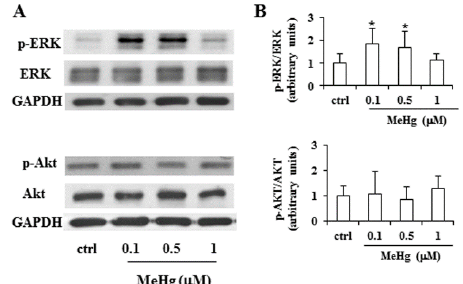
Figure 3. Effects of low doses of MeHg on ERK and Akt phosphorylation. Nthy-ori-3-1 cells were treated for 6 h in the absence or presence of MeHg, at the concentrations of 0.1, 0.5 and 1 µM. ( A ) Immunoblot analysis of active, phosphorylated ERK (p-ERK) and phosphorylated Akt (p-Akt), and total form of the enzymes (ERK, Akt), was performed by western blotting. GAPDH was used as loading control. ( B ) Densitometric analysis from four immunoblot of p-ERK / ERK and p-AKT / AKT. Values are expressed as a ratio over the loading control (arbitrarily assigned as 1). Untreated cells were used as control and indicated as control. Statistical analysis was performed using the Tukey–Kramer multiple comparisons test. * p < 0.05 vs. control.